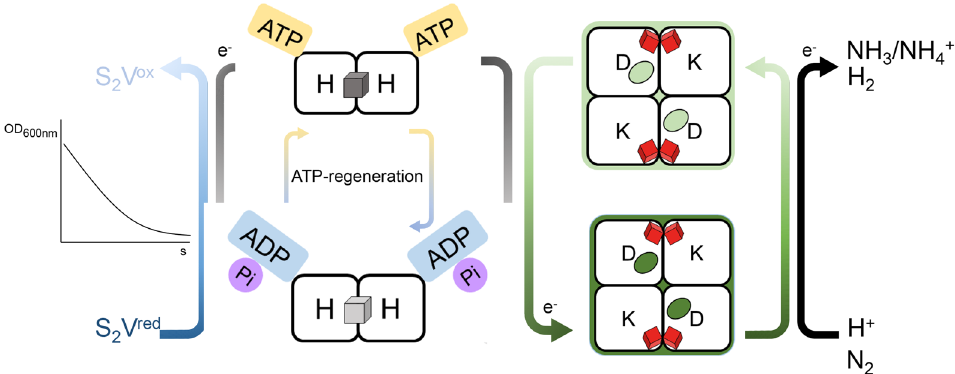
Figure 1. Schematic overview of nitrogenase activity and activity determination using S 2 V red . The flow of electrons from S 2 V red to protons (H + ) or N 2 via NifH and NifDK is shown. At NifDK, H 2 or NH 4+ (the dominating form at pH 7) is produced. ATP is regenerated from ADP and phosphocreatine by the action of creatine phosphokinase. Nitrogenase activity is determined by measuring the decrease in absorbance at 600